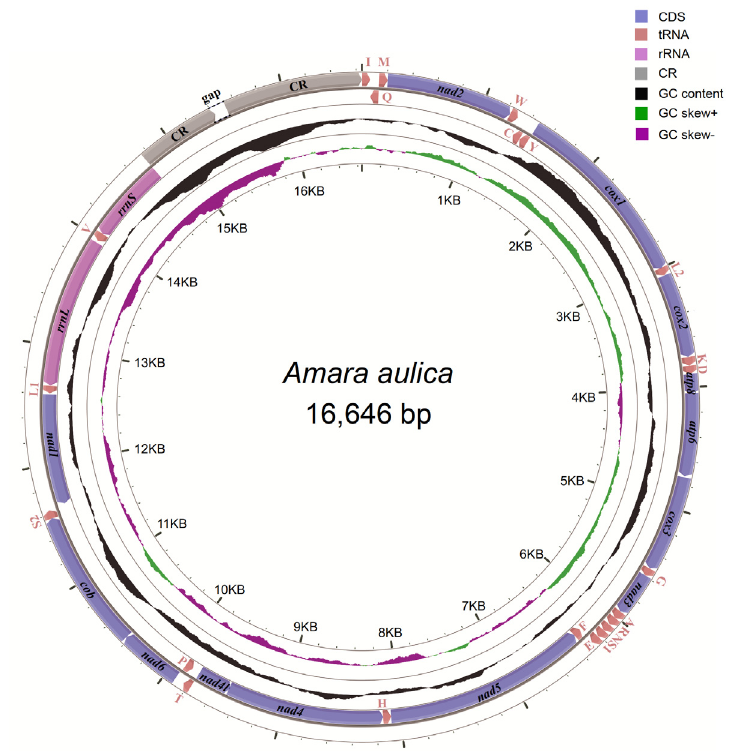
Figure 1. The structure of the mitochondrial genome of Amara aulica . Arrows indicate the direction of gene transcription. The inner circles show the GC content and the GC-skew values.